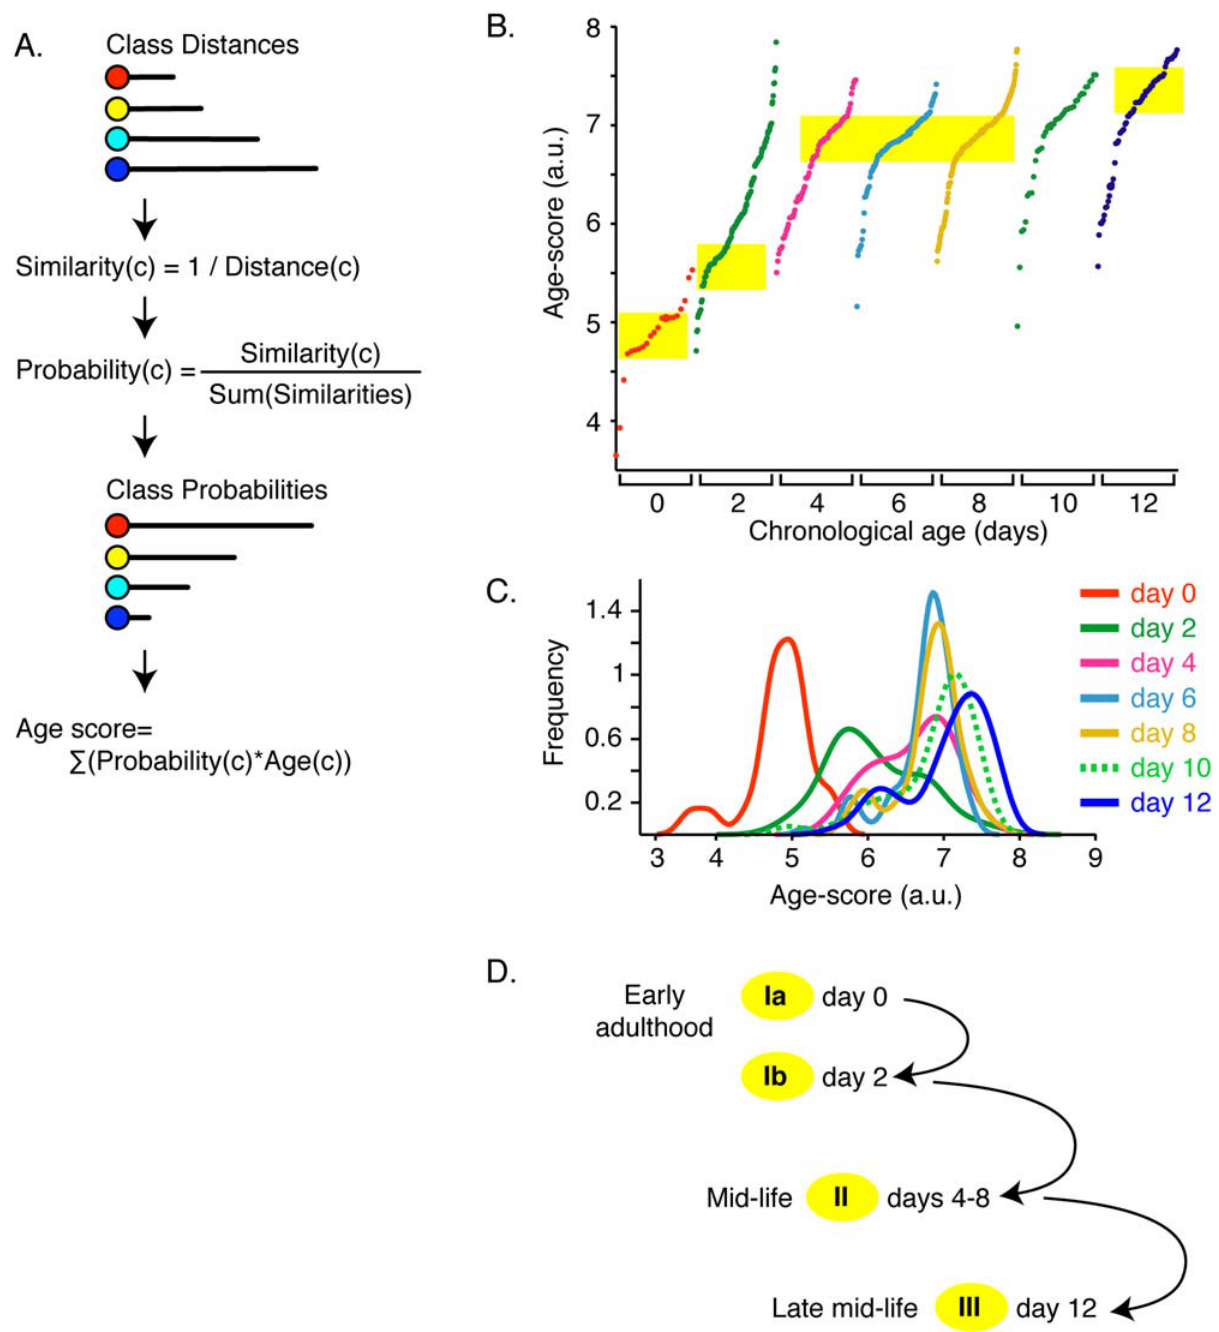
Figure 3. Age-scores for normal animals revealed distinct stages of adult morphology. (A) Age-scores were generated by converting each image’s class distance into a class-probability, which were combined with class ages to produce an age-score. For training, 85 images from fem- 1(hc17) adults aged day 0 to 12 were used for each class. (B) Age-scores for every test image from normal animals. The horizontal axis was ordered primarily by known age, and secondarily by age-scores. The yellow bars highlight inflections in the age-score distribution for images in each age group. These inflection regions constitute the stable morphology states depicted in (D). The number of test images for days 0–12 was 21, 143, 74, 91, 177, 40, and 62, respectively. (C) Probability distributions of age-scores, which can be interpreted as continuously sampled histograms with peaks indicating the most probable age-score. (D) Distinct stages of adulthood as determined by distribution of age-scores. Yellow ovals for each age state correspond to the inflections in the age-score distribution in part (B). See Table 1 and text for statistics. doi:10.1371/journal.pone.0002821.g003 compared to 0.68 ( p =2.17 6 10 2 17 ) for the terminal bulb. images of the corpus identified similar morphological states as for the terminal bulb, although with weaker statistics. Within this Interestingly, the morphological state of these two pharynx regions group of images, a Pearson correlation between predicted and was synchronized in some animals. In particular, the shift between chronological age for the corpus images was 0.47 ( p = 6.46 6 10 2 8 ) states I and II resulted in a low correlation between predicted and